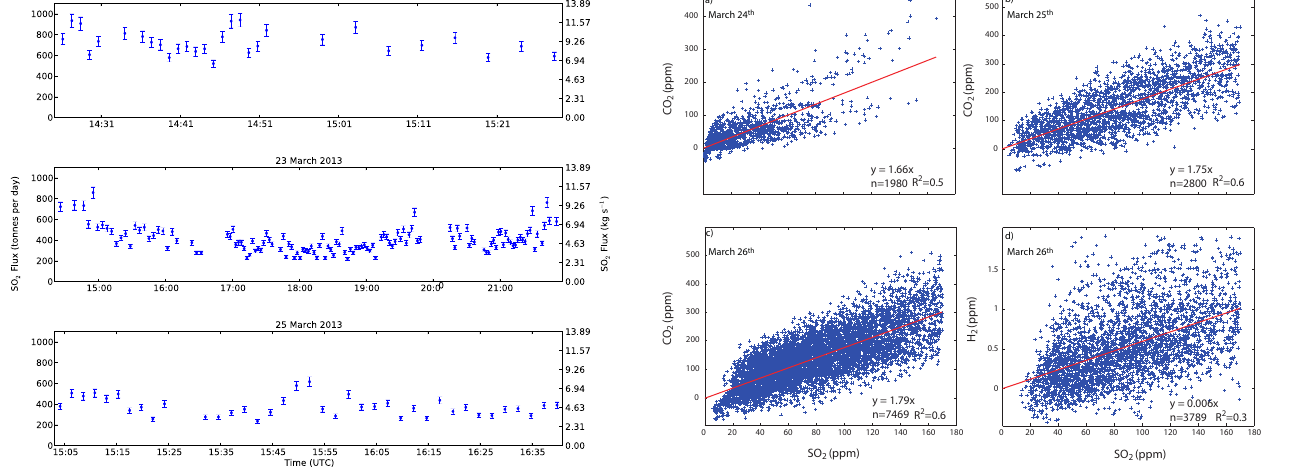
Figure 3 Moussallam et al., Figure 4. CO 2 vs. SO 2 and H 2 vs. SO 2 scatter plots from 3 days Figure 3. SO 2 fluxes shown in td − 1 and kgs − 1 for 3 days of obser- of sampling of the Turrialba mixed plume, directly south of the vations using DOAS horizontal scanning directly above the summit Figure 4 Moussallam et al., 2010 vent using a multi-species gas-sensing system. (a) 17:52 to from a fixed observation point 2.0km away (horizontal distance) 18:58UTC, 24 March 2013. (b) 20:24 to 21:57UTC, 25 March from the summit. Only cloud-free periods with scans clearing the 2013. (c) 22:05UTC, 25 March 2013, to 02:14UTC, 26 March plume on both sides are reported. 2013. (d) 00:10 to 02:14UTC, 26 March 2013. Regression lines are shown in red and corresponding parameters are displayed in the lower right corner of each